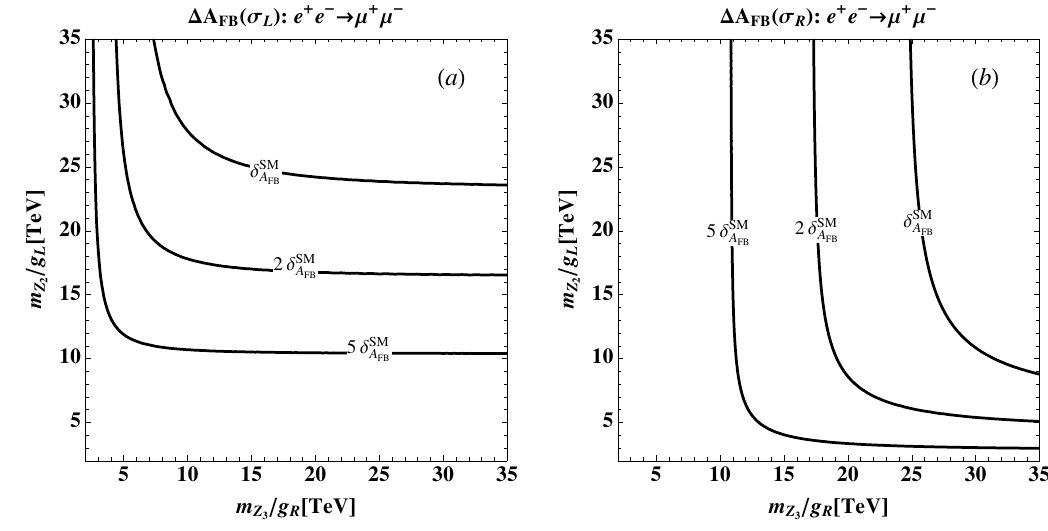
Figure 2 . The contours of (cid:1) A FB for the process e + e (cid:0) ! (cid:22) + (cid:22) (cid:0) where the other settings